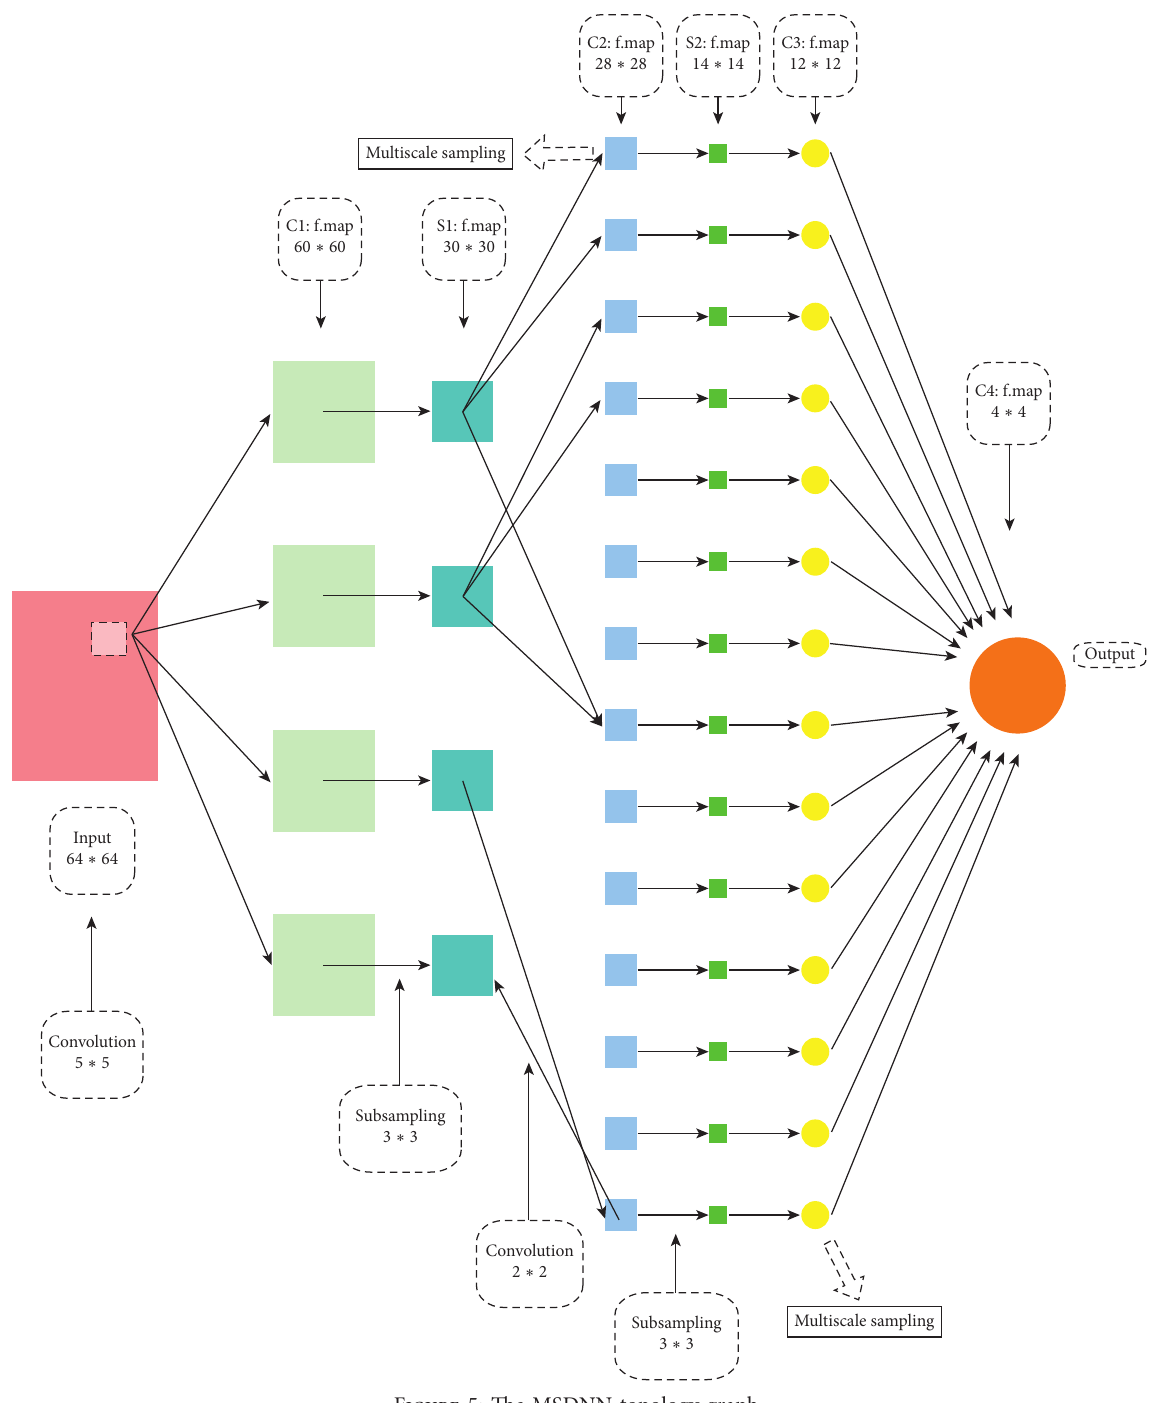
Figure 5: The MSDNN topology